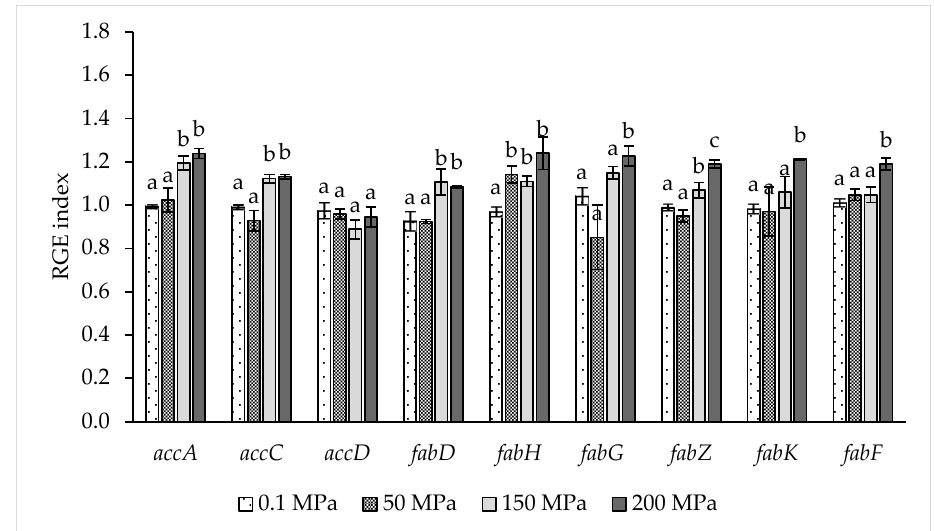
Figure 2. Relative gene expression (RGE) index of Lb. paracasei fatty acids biosynthesis genes accA, accB, accD , fabD , fabH , fabG , fabZ , fabK and fabF in relation to homogenization pressure. RGE index